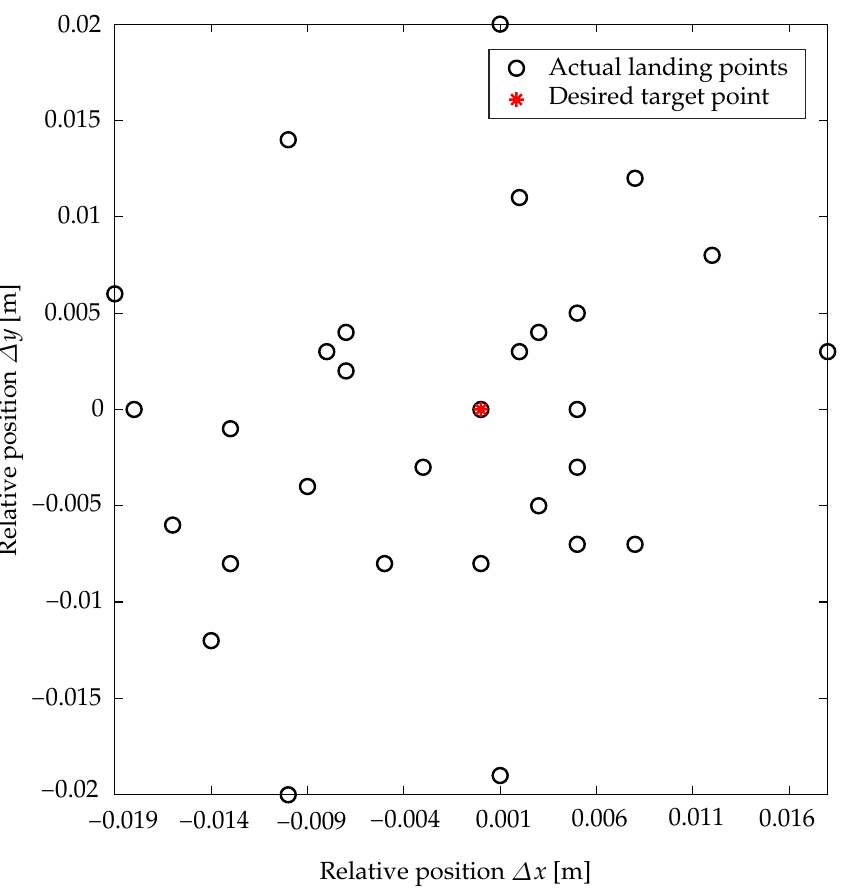
Figure 15. The actual landing points measured in 30 successive